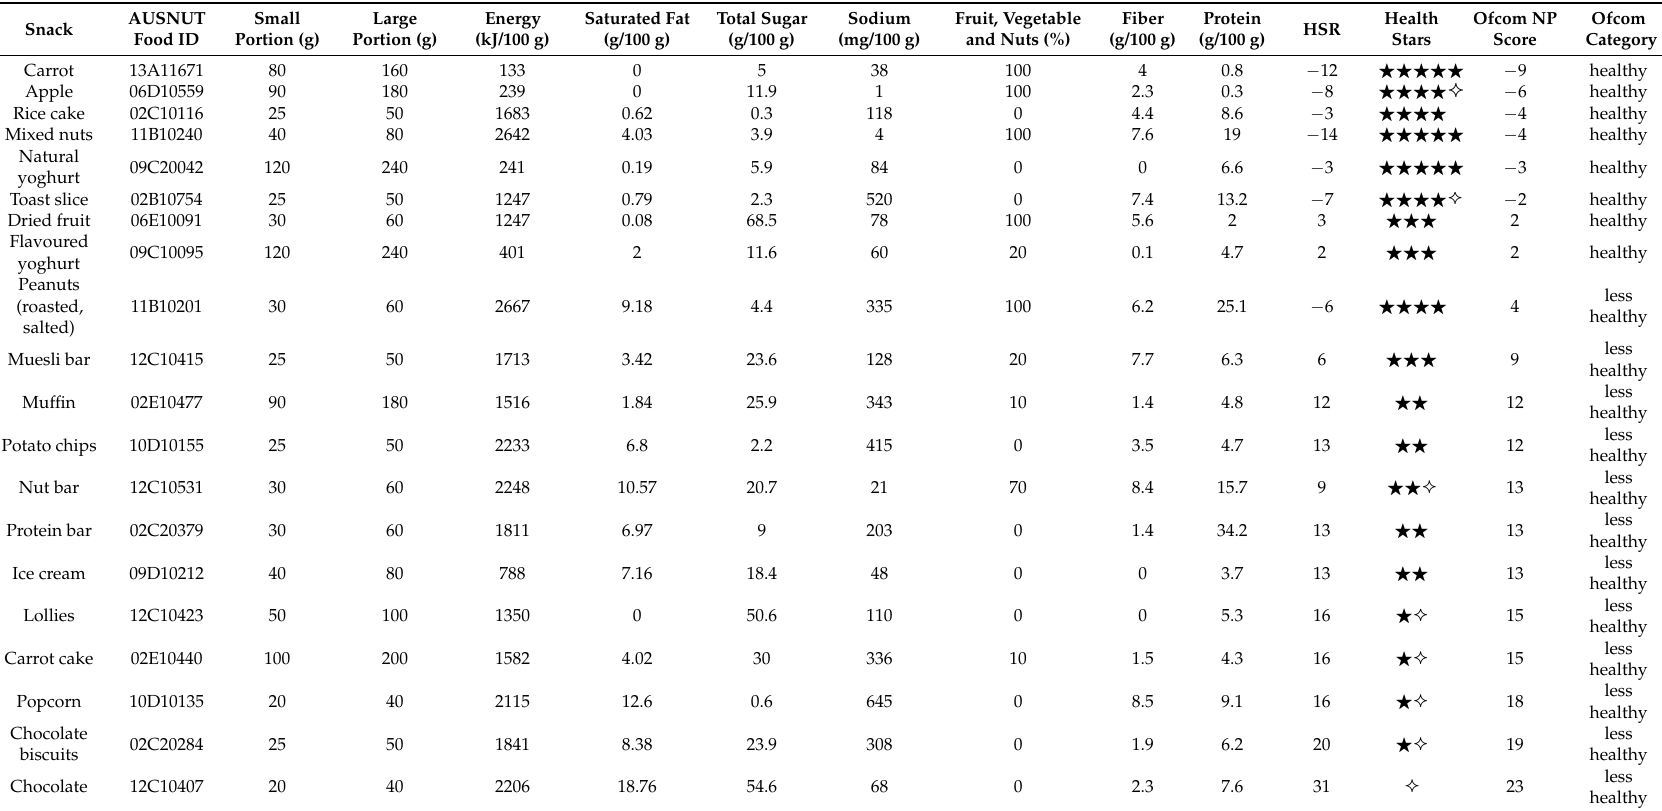
Table A1. Characteristics of the snacks ( N = 20) evaluated by experts and lay participants for the sorting task. Ofcom Nutrient Profile Score [17] Health Star Rating (HSR) scores and Health Stars were calculated [18] according to the nutrition information per 100 g derived from the AU food database (AUSNUT).